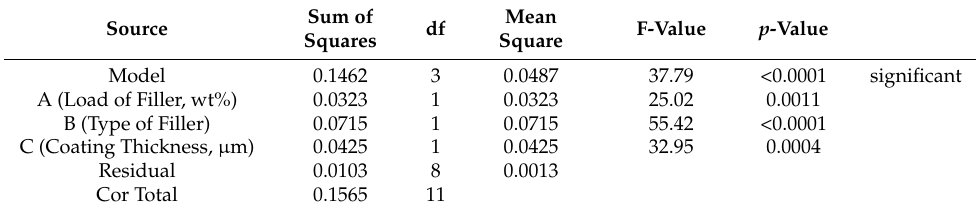
Table 2. ANOVA-based model of corrosion current density.